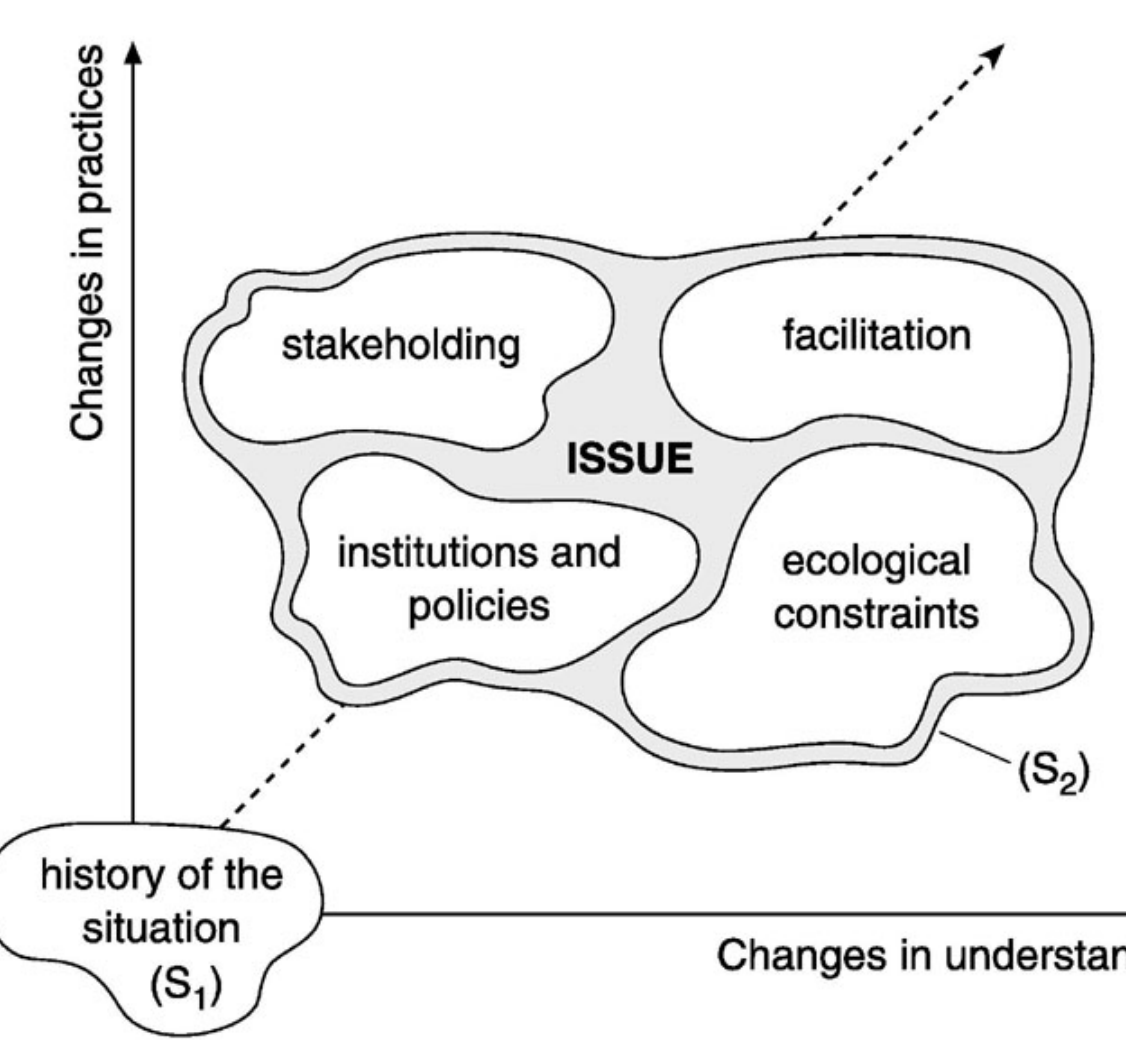
Fig. 2 . In the SLIM (Social Learning for the Integrated Management and sustainable use of water) research, we have been concerned in particular with how six variables interact and are mediated by learning processes to shape issues and transform particular situations. These variables include history, stakeholding, facilitation, institutions and policies, and ecological